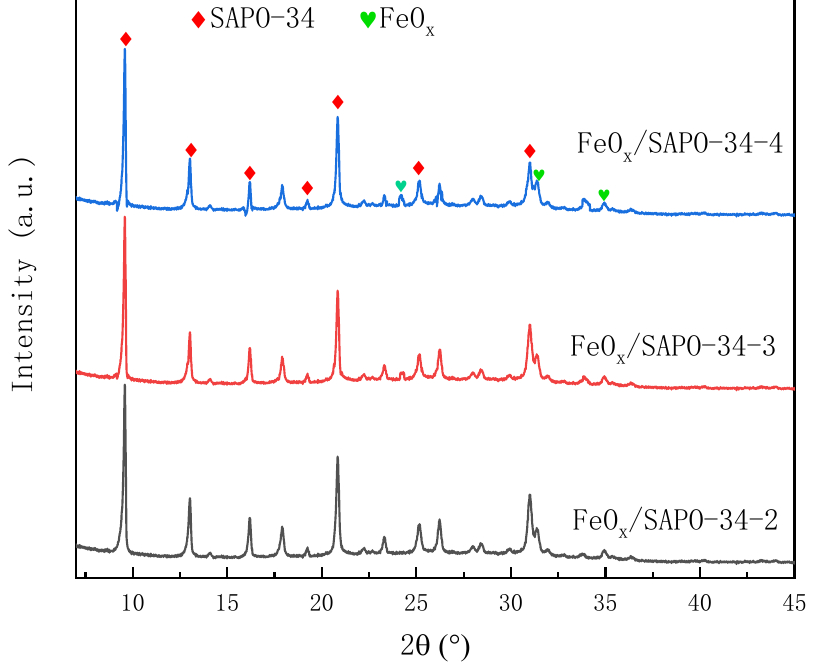
Figure 1. XRD patterns of the samples: FeO x /SAPO ‐ 34 ‐ 2, FeO x /SAPO ‐ 34 ‐ 3 and FeO x /SAPO ‐ 34 ‐ 4.